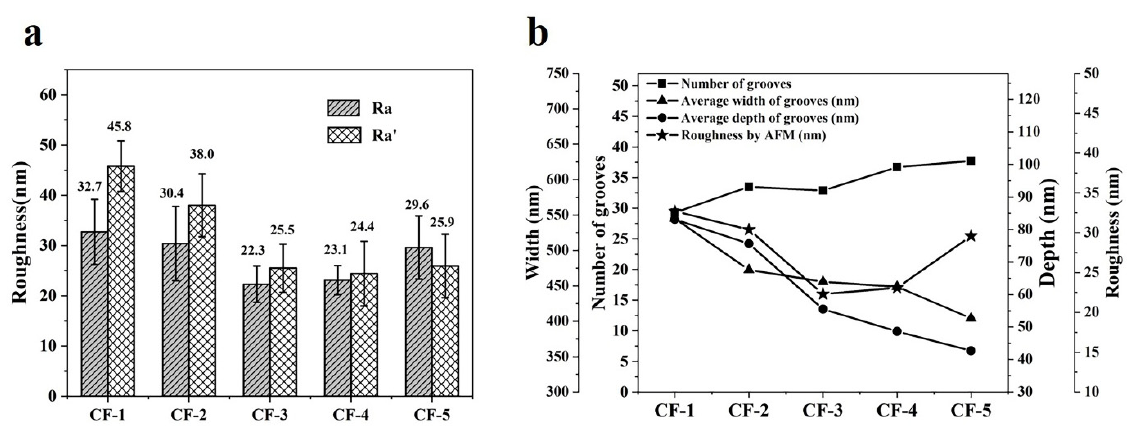
Figure 8. ( a ) Ra and Ra ′ of CFs; ( b ) the relationship between groove parameters and surface roughness of CFs.